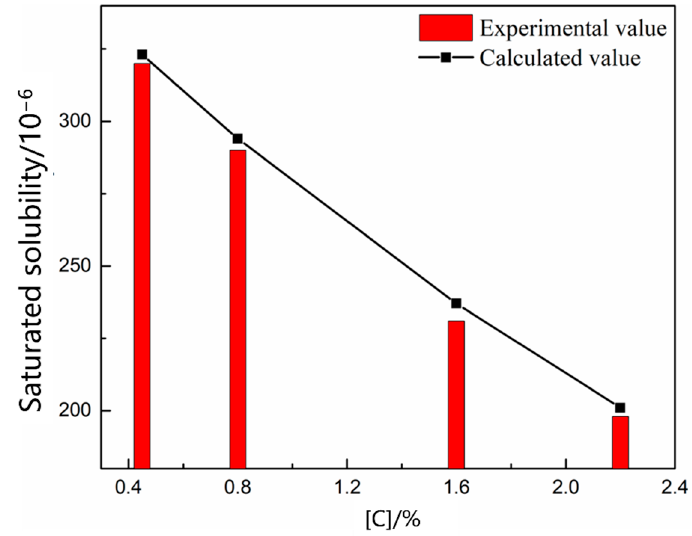
Figure 2. Effect of carbon content on nitrogen solubility. Nitrogen exists in liquid monoatomic form in the liquid metal. The dissolution reaction and equilibrium constant are shown in Equations (1) and (2) [19]. Equation (3) is obtained on the gas equilibrium partial pressure, reaction constant, and reaction activity